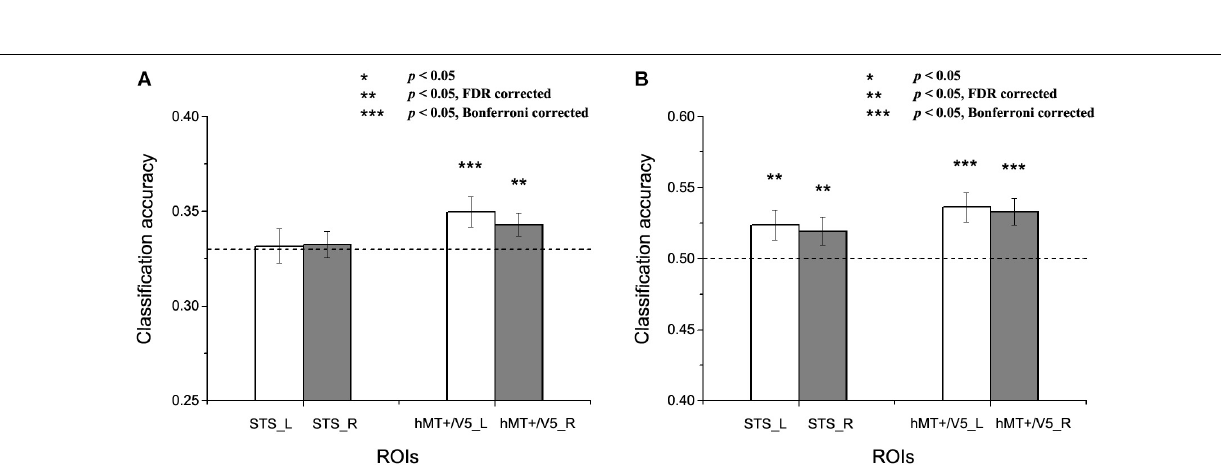
Frontiers in Neuroscience | www.frontiersin.org